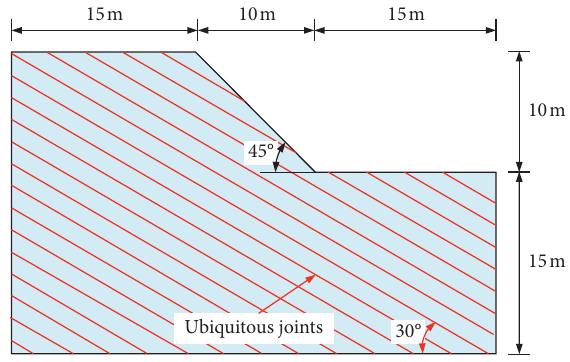
Figure 1: The schematic of the 2D slope and its dimension. Table 1: Geotechnical parameters of the numerical model.